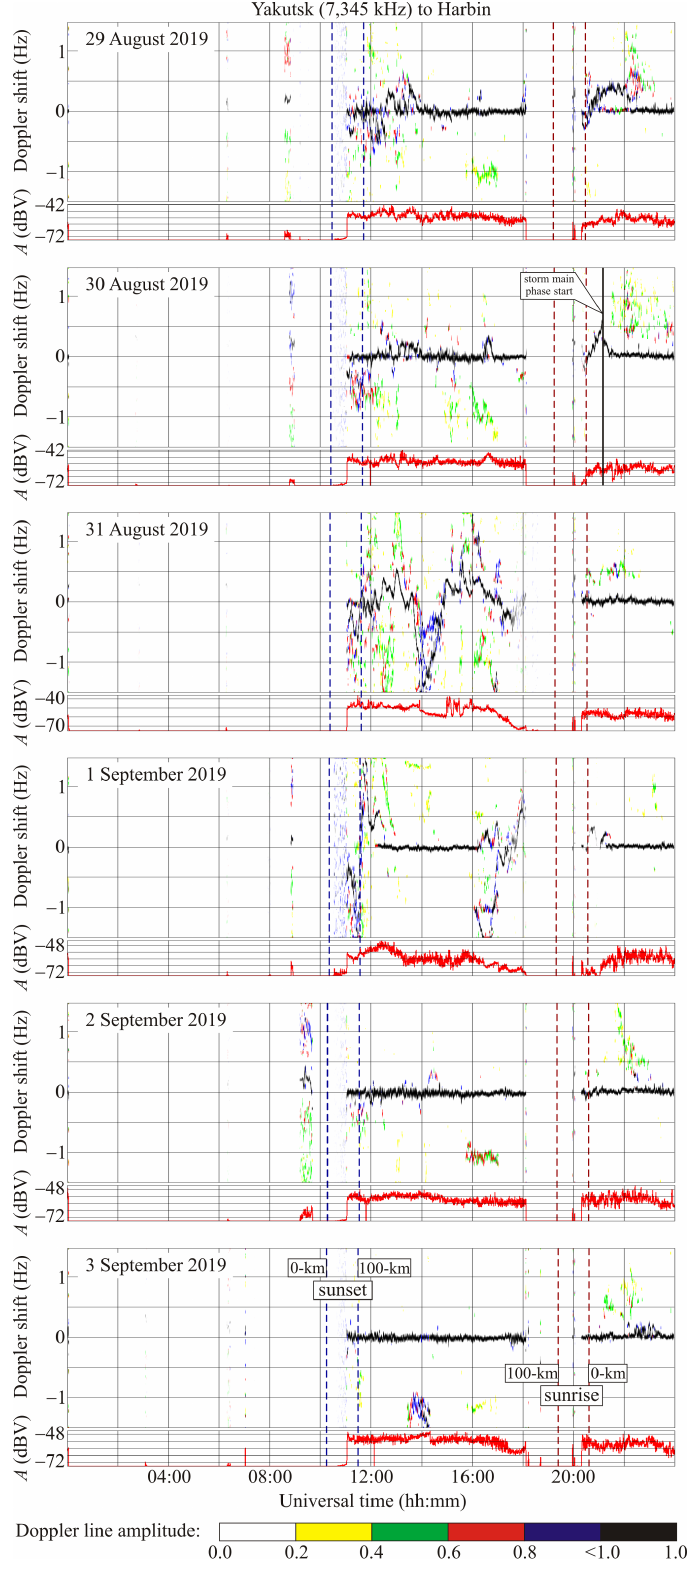
Figure 11. Same as Fig. 5 but for the Yakutsk to Harbin radio wave propagation path at